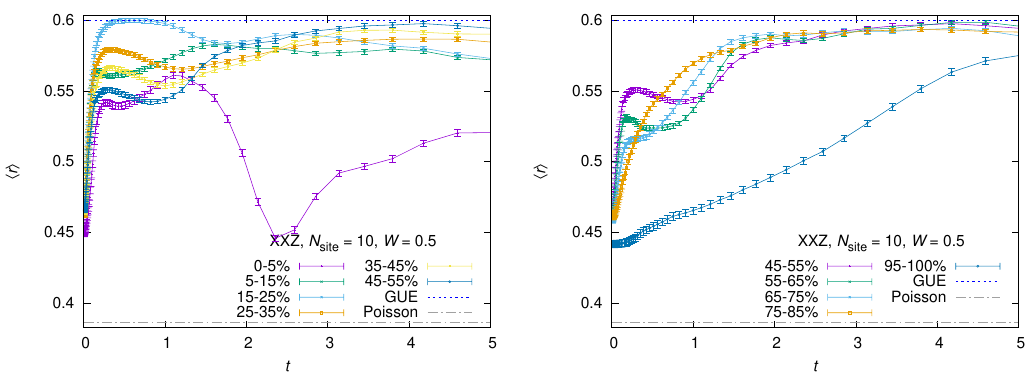
Figure 21 . Plot of h r i for the two gaps between the three largest exponents for XXZ, N site = 10, W = 0 : 5. Better agreement with GUE (both the value and time window) can be seen at the center of the energy spectrum, which is consistent with the fact that the center of the energy spectrum is in the ergodic phase while the edges remain MBL.